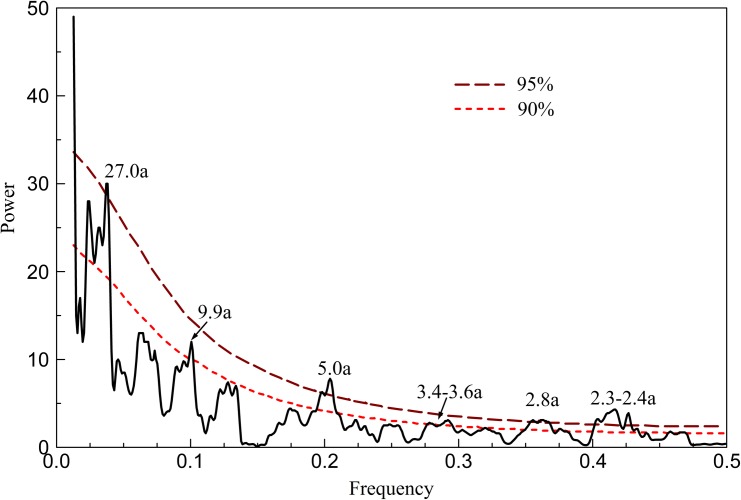
Spectrum analysis result of the reconstructed mean temperature.The dashed line indicates the 95% and 90% confidence levels.